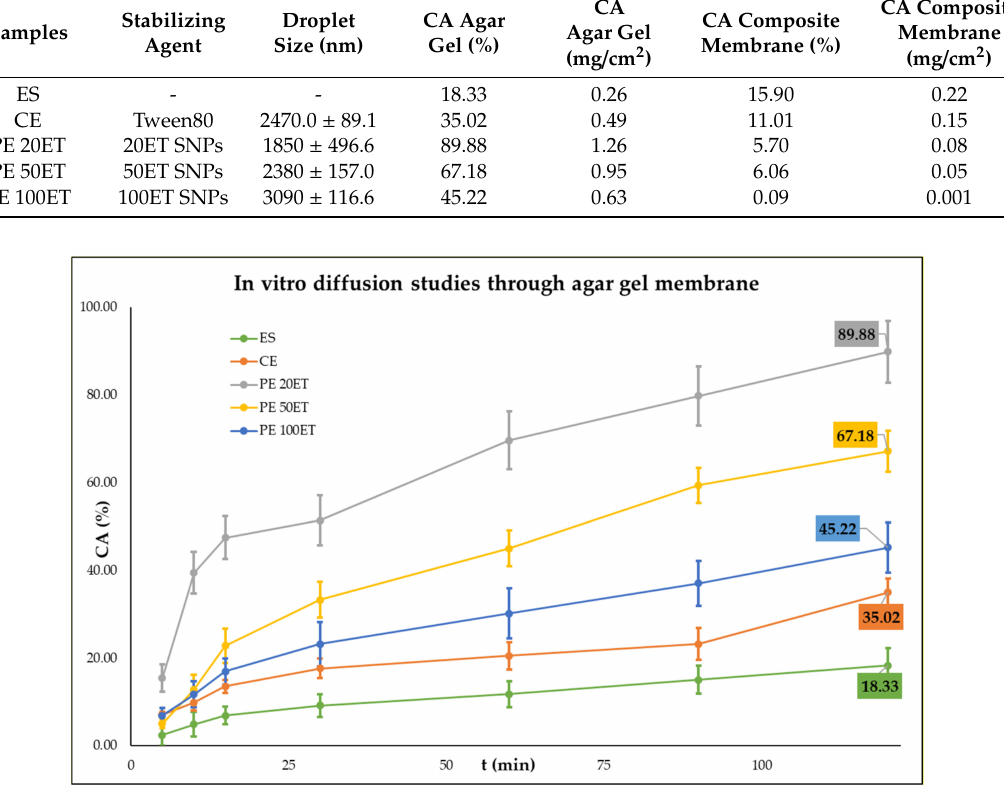
Figure 2. In vitro di ff usion studies through agar gel membrane. ES: ethanolic solution, CE: conventional emulsion, PE: Pickering emulsion, CA: cumulative TIO amount after 2 h. C TIO = 3.58 mg / mL.